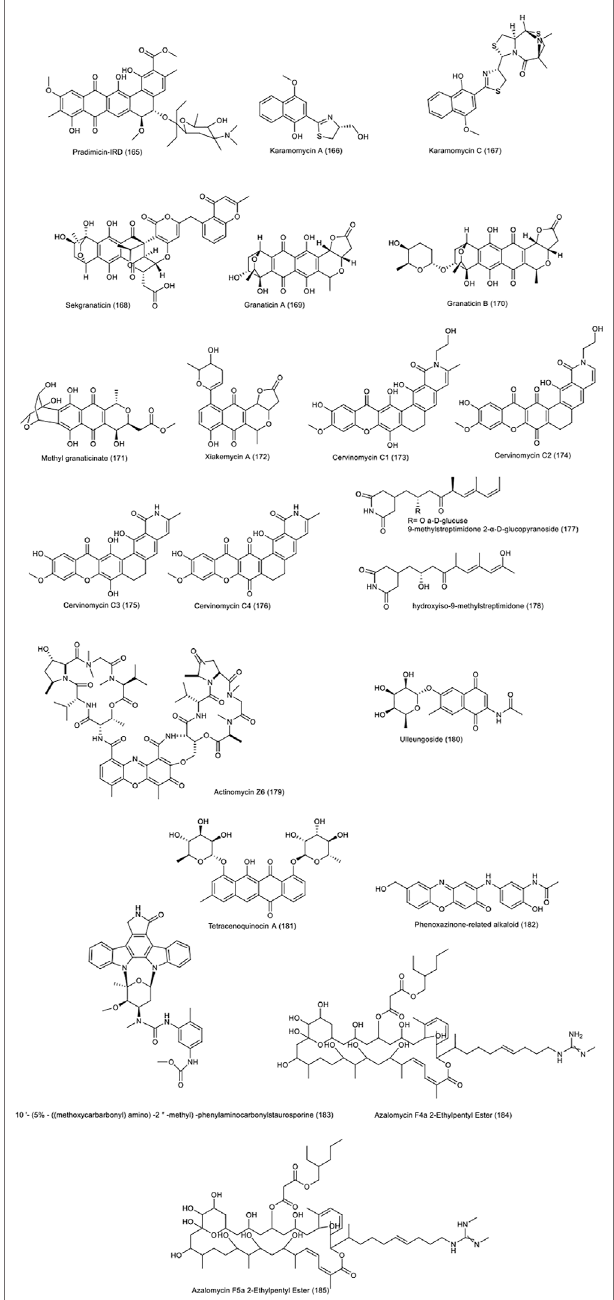
FIGURE 6 | Chemical structure of NPs produced by terrestrial strains of